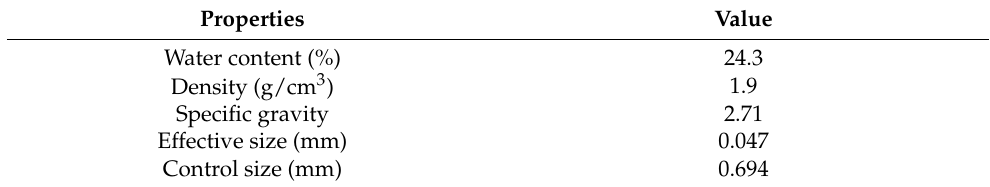
Figure 7. Simulated contaminated soil layer. Table 2. Physical parameters of the clay (Data from